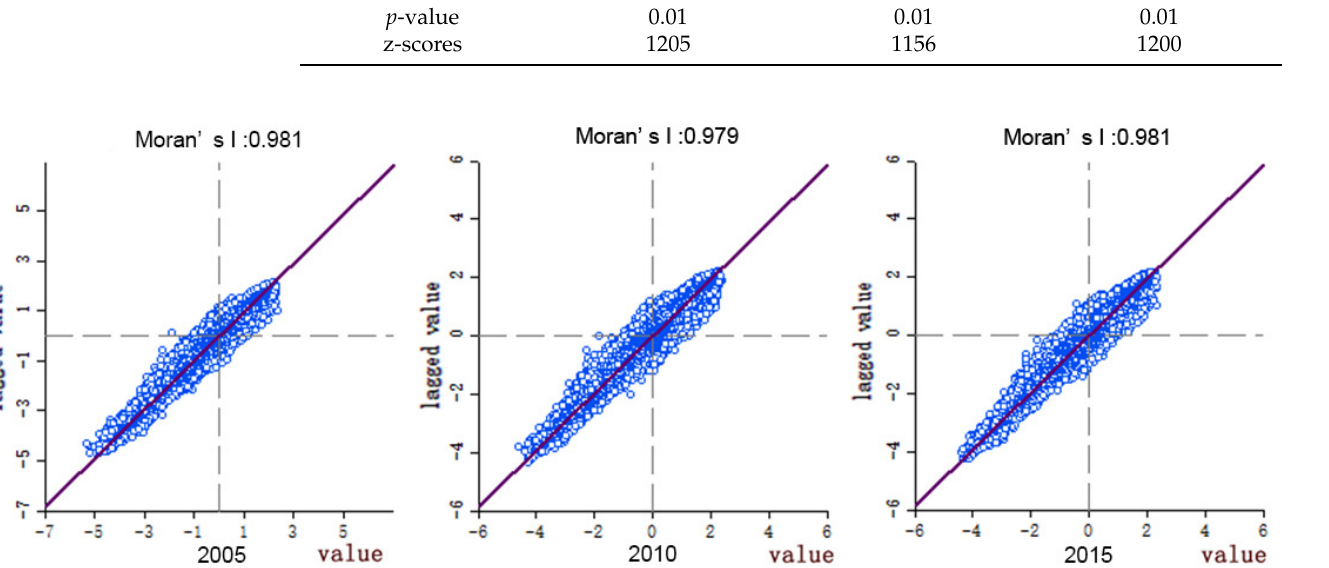
Figure 8. The Lisa clustering map of YDR in 2005, 2010, and 2015: (1) high ‐ high denotes spatial clustering of similar high values, (2) low ‐ low denotes spatial clustering of similar low values, (3) low ‐ high clustering denotes low values surrounded by high values, and (4) high ‐ low clustering de ‐ notes high values surrounded by low values. 4.4. Scenario Simulation of ES Pattern It can be seen from Figure 9 and Table 6 that under the three scenarios, the sum of Safety, Relative safety, and General safety is 81.60%, 81.03%, and 81.76%, respectively. The proportion of unsafe and relatively unsafe states in 15 cities is: Shanghai > Suzhou > Wuxi > Changzhou > Hangzhou > Taizhou > Yangzhou > Nantong > Nanjing > Zhenjiang > Jiax ‐ ing > Huzhou > Shaoxing > Ningbo > Taizhou. Among them, the sum of insecurity and relative insecurity in Shanghai accounts for more than 99% of the whole study area and less than 1% in Taizhou.